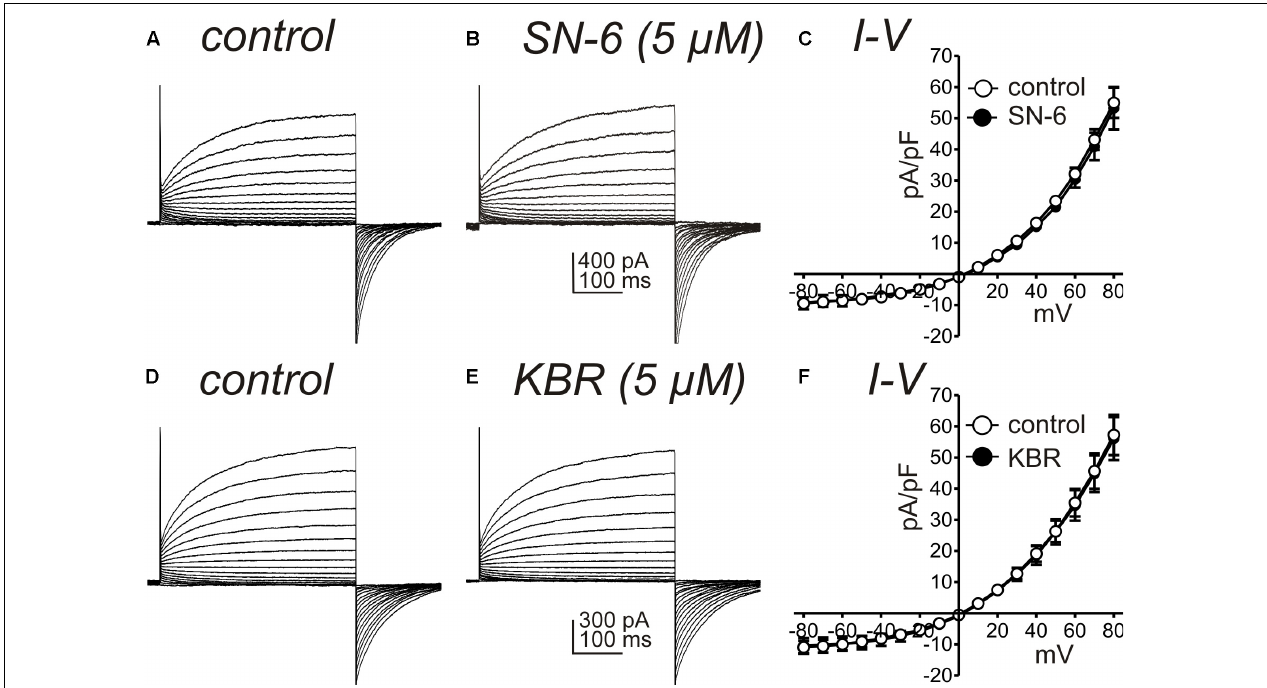
FIGURE 7 | Effects of NCX antagonists on ANO1 currents expressed in HEK 293 cells. (A,B) show ANO1 current responses from HEK 293 cells transfected with the AC splice variant of Ano1 to step protocols from –80 mV to +80 mV before and in the presence of SN-6 (5 µ M). A symmetrical Cl − gradient was established for these experiments (i.e., external and internal solutions were Solutions IV and VII, respectively). SN-6 had no effect on the ANO1 currents, and data from 5 cells are summarized in (C) . (D,E) Show ANO1 current responses from HEK 293 cells transfected with the AC splice variant of Ano1 to step protocols from –80 mV to +80 mV before and in the presence of KB-R7943 (KBR; 5 µ M). Peak currents at 400 ms during step depolarization were divided by cell capacitance and reported as current densities (pA/pF). KBR had no effect on the ANO1 currents, and data from 5 cells are summarized in (F)